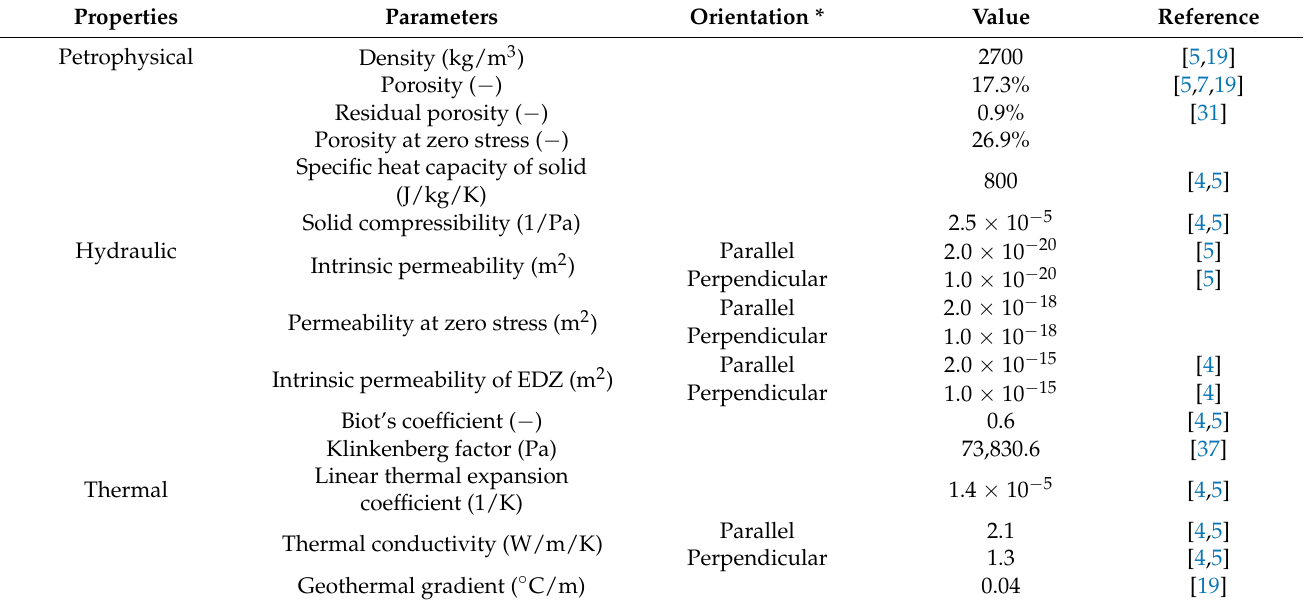
Table 1. The main petrophysical, hydraulic, and thermal parameters of the COx claystone used in the simulations.